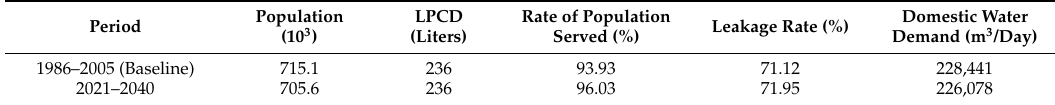
Table 3. Parameters used for projecting domestic water demand under baseline and future scenarios.